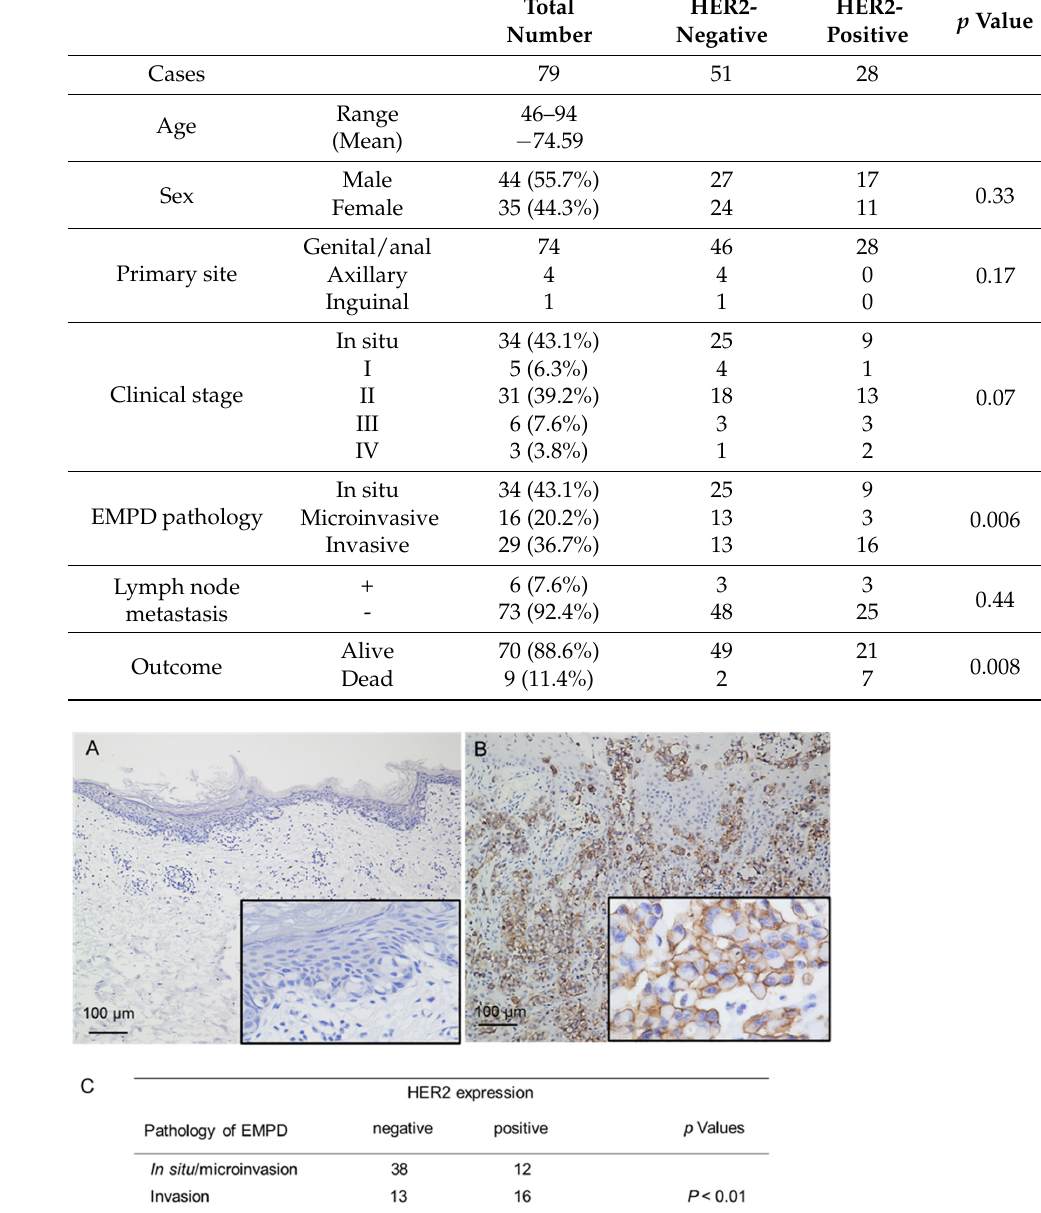
Figure 5. There is a significant correlation between positive HER2 immunostaining and the presence of invasive lesions. ( A , B ) Representative images of immunohistochemical staining for HER2; ( A ) in situ extramammary Paget’s disease (EMPD); ( B ) invasive EMPD. ( C ) The 79 cases were classified as HER2-negative or HER2-positive. HER2-negative is significantly more common in situ/microinva- sive EMPD tumors than in invasive EMPD ( p < 0.01, Fisher’s exact probability test).